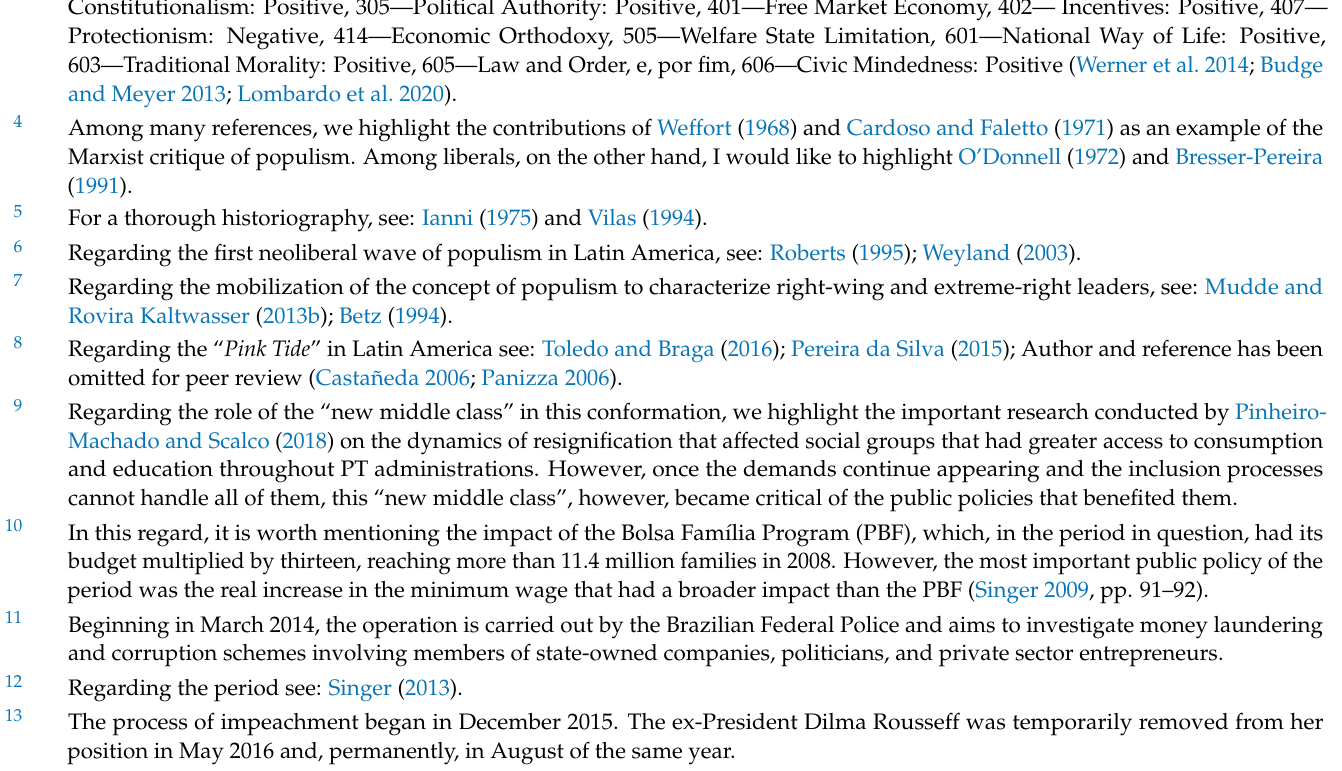
As explained by Roger Eatwell, right populism should be seen as a global phenomenon, challenging liberal democracies; “Brexit and Trump actually followed the much longer rise of national populists across Europe, such as Marine Le Pen in France, Matteo Salvini in Italy and Viktor Orb á n in Hungary. They are part of a growing revolt against mainstream politics and liberal values”, (Eatwell and Goodwin 2018, p.